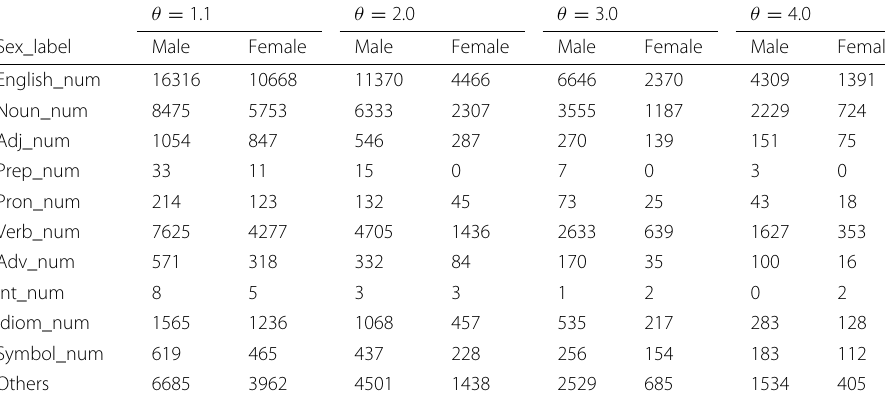
Classification algorithm